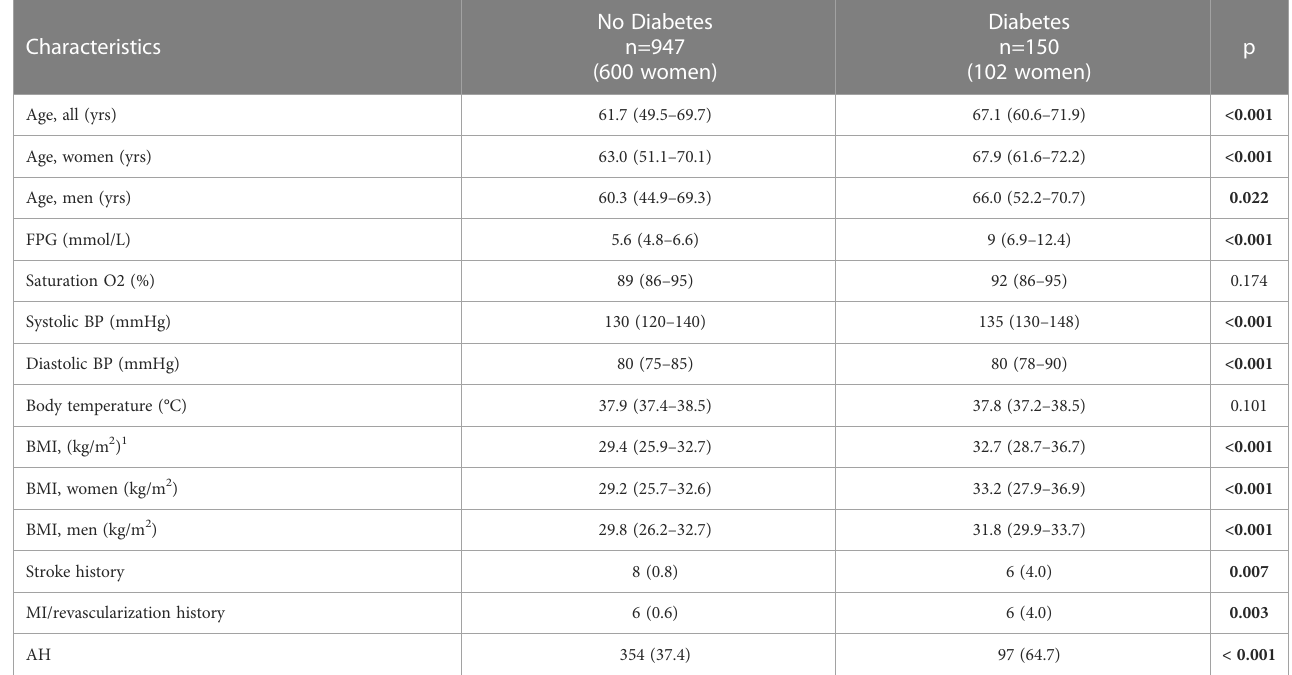
TABLE 1 Some characteristics of patients with COVID-19 depending on their “ diabetes mellitus ” diagnosis at the time of admission to the infectious disease hospital.